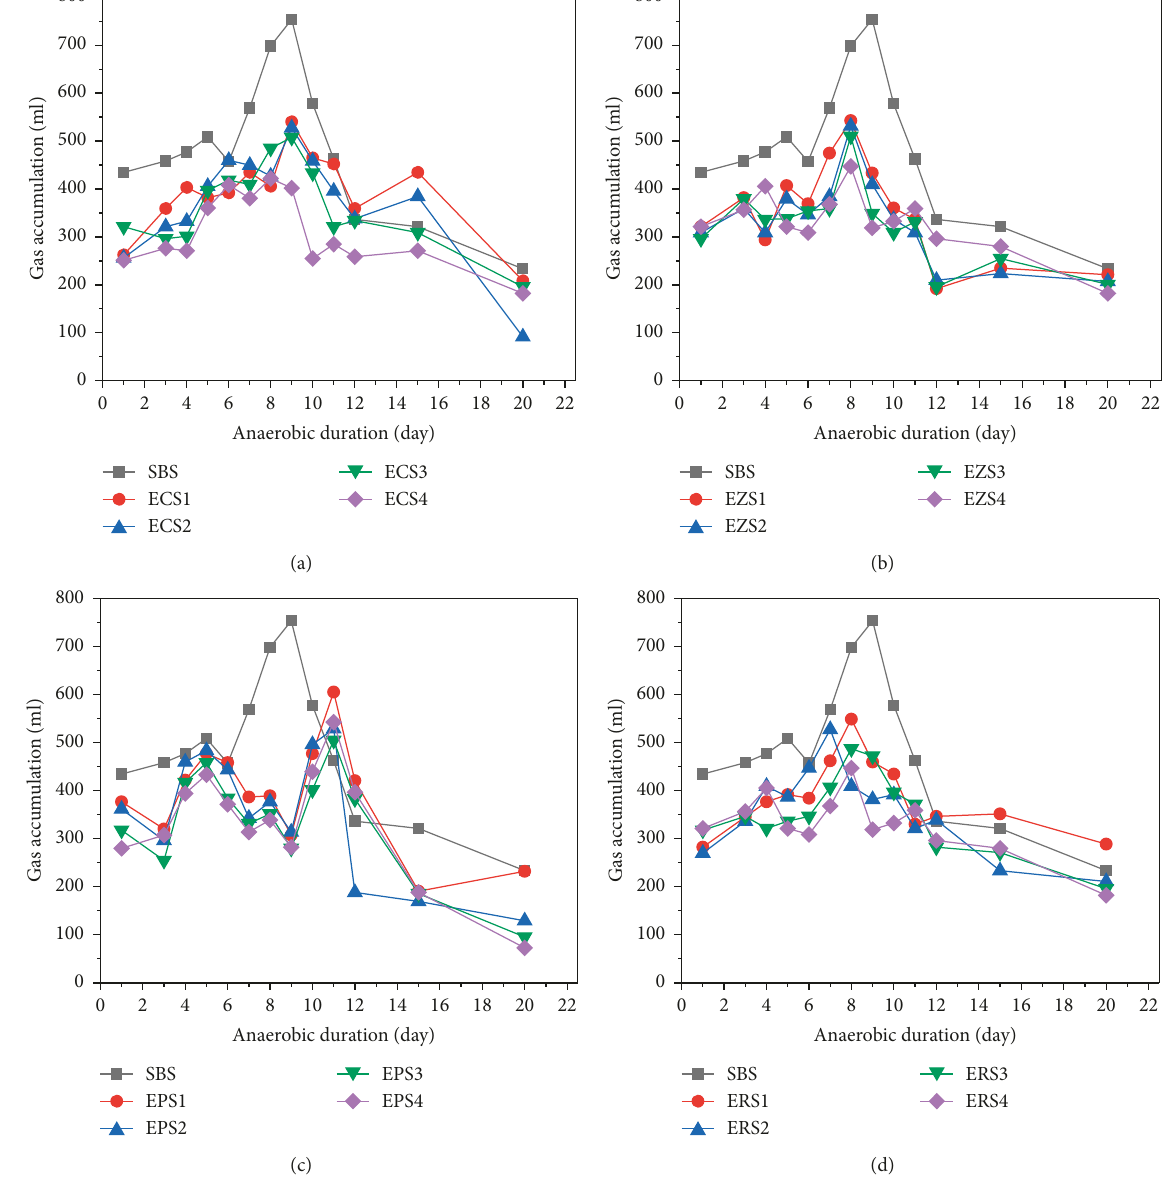
Figure 5: Effect of copper, zinc, chromium, and lead on biogas volume generated during the